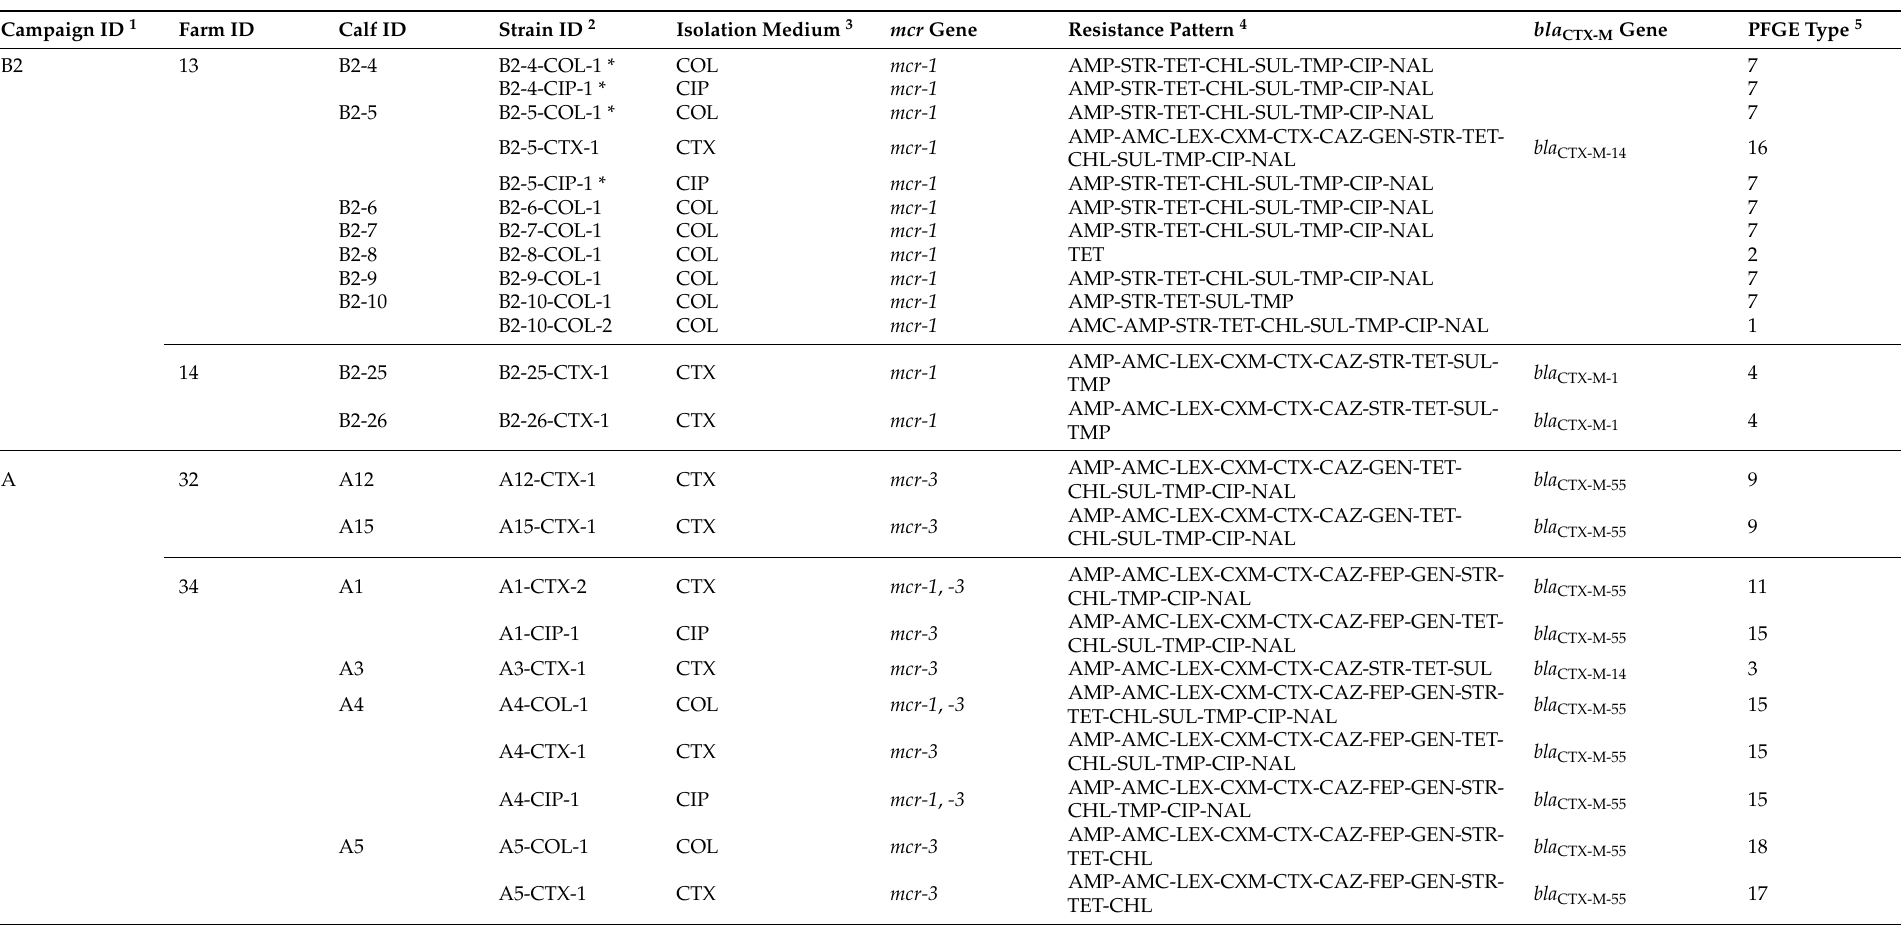
Table 1. Characterization of 44 mcr -positive E. coli strains isolated from French veal calves at the time of